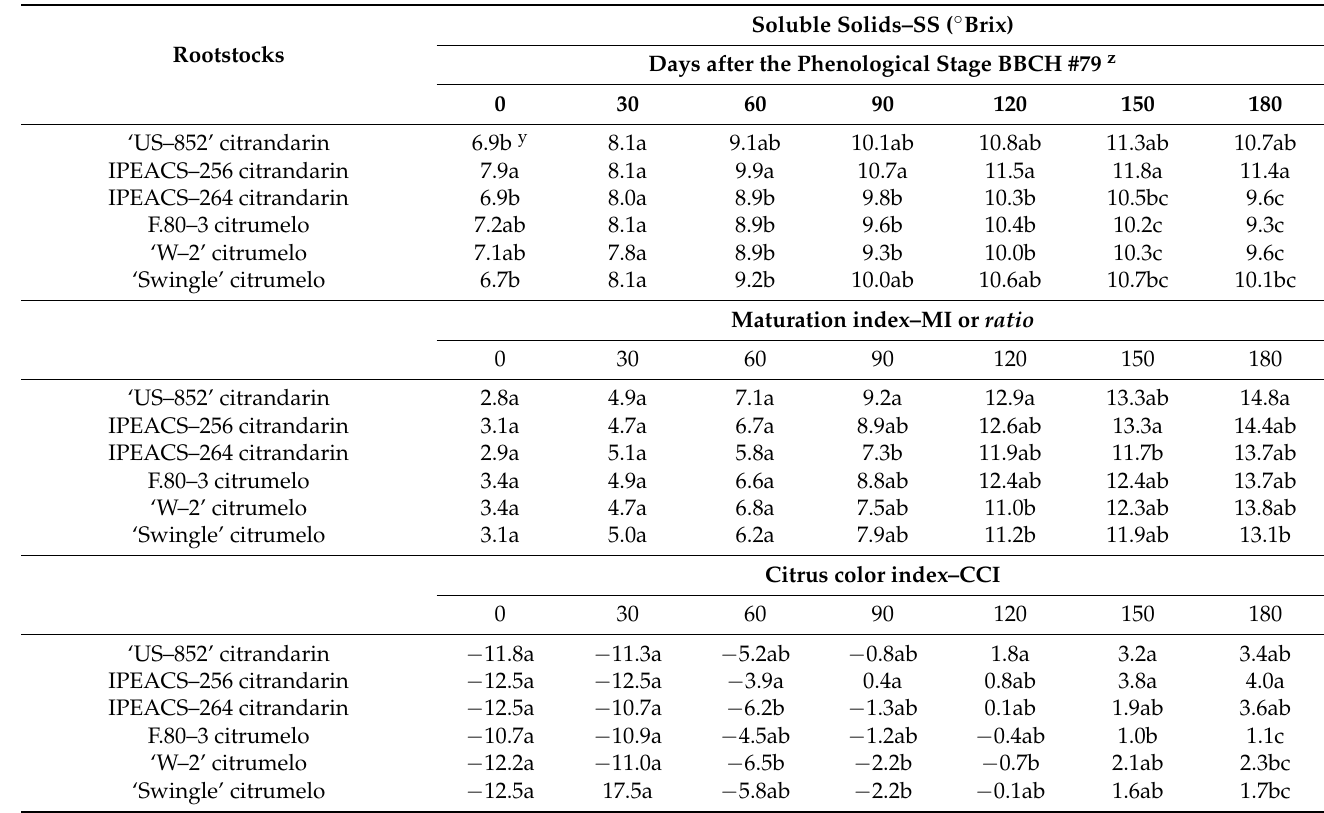
Table 2. Soluble solids, maturation index or ratio , and citrus color index of ‘Valencia’ orange fruits when trees are grafted on different ‘Trifoliata’ hybrid rootstocks at Rancho Alegre at different times after the phenological stage BBCH #79.